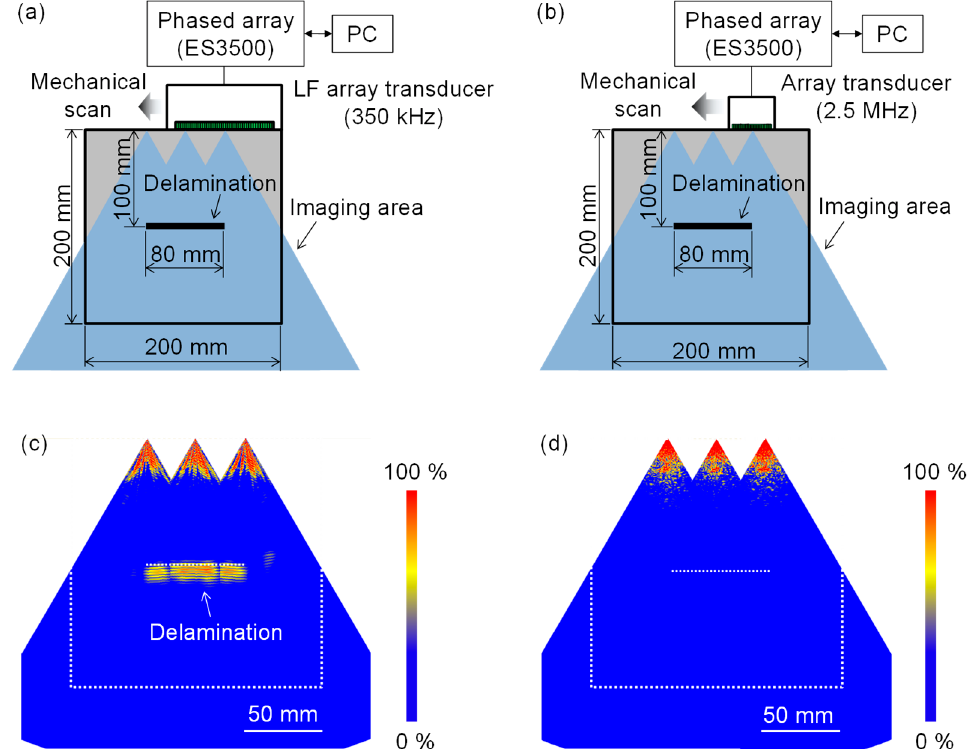
Figure 9. Experimental configurations for visualizing delamination in concrete specimen and imaging results obtained with LF and 2.5 MHz array transducers. ( a , b ) Experimental configurations for the LF and 2.5 MHz array transducers, respectively; ( c , d ) imaging results obtained with the LF and 2.5 MHz array transducers, respectively.